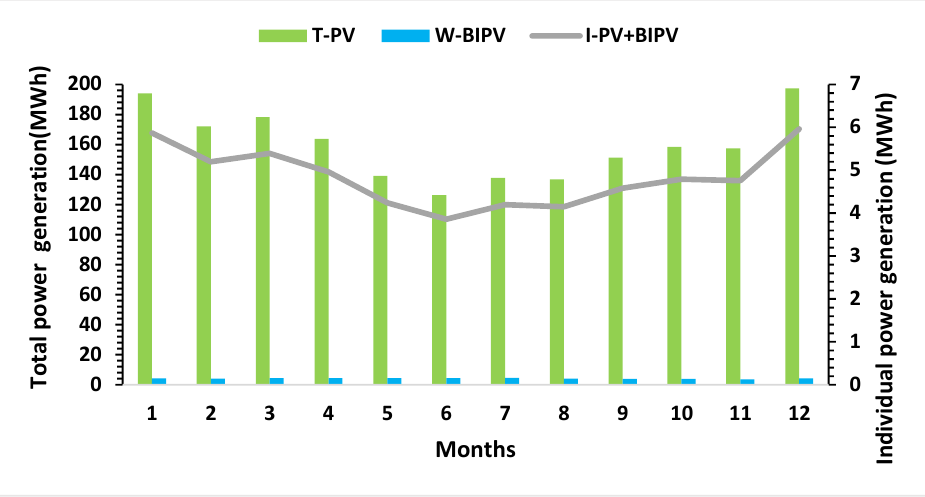
Figure 13. Average monthly photovoltaic generation for rooftop solar panels (T-PV), for panels integrated in window glazing (W-BIPV), and for both systems per individual residence (I-PV+BIPV).